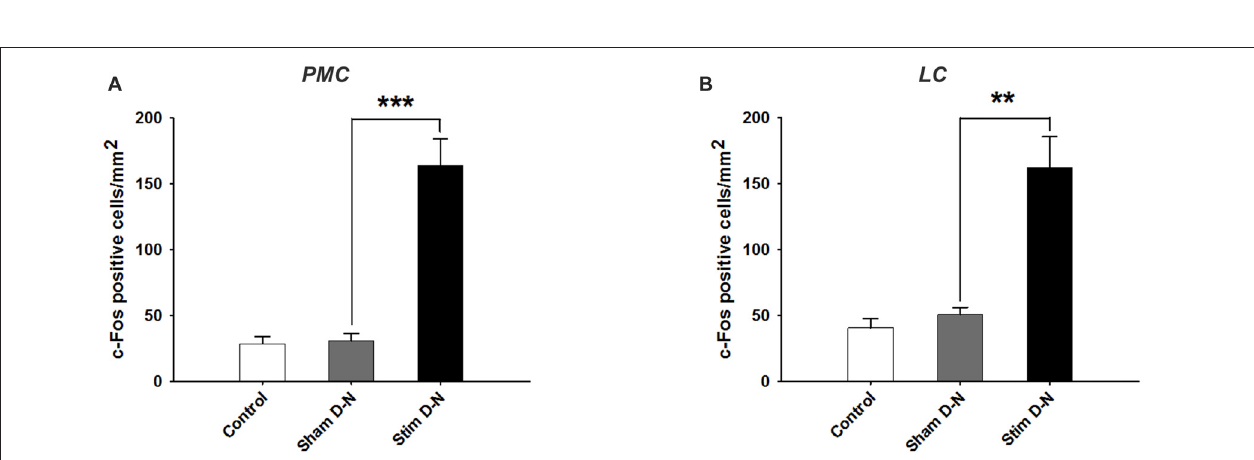
FIGURE 6 | Expression of cFos immunoreactive cells in the PMC and LC. Cumulative data showing the means and SEM of cFos expression for D-N animals in (A) PMC and (B) LC. Control n = 6, Sham D-N n = 6 and Stim D-N n = 7. t -test, ∗∗ p < 0.005 and ∗∗∗ p <